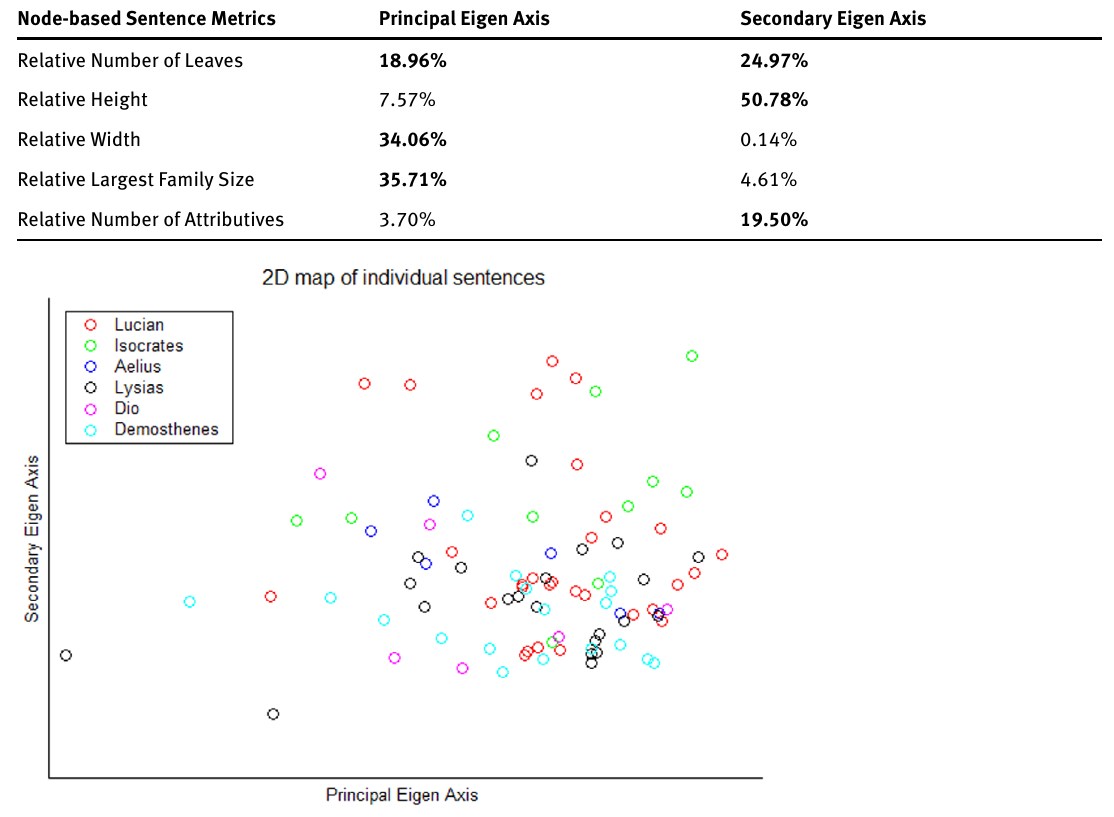
Fig 10. Plots of the sentence dataset on the plane of the two dominant eigenvectors. Each sentence is represented by one point (circle) in this